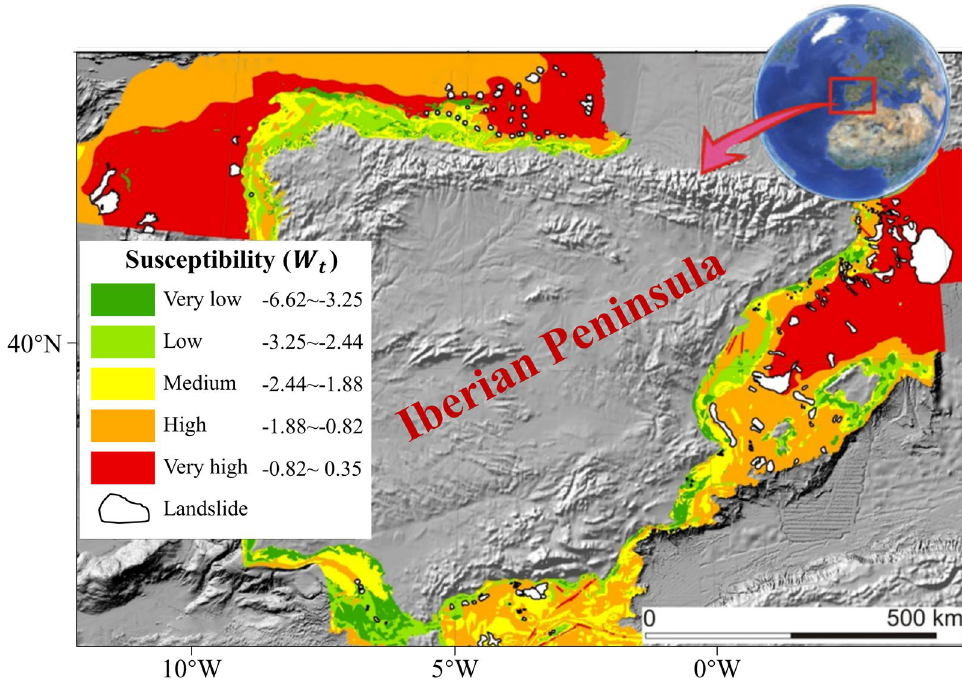
Fig. 23 Susceptibility map of the Spanish continental margin (modified from Borrell et al.